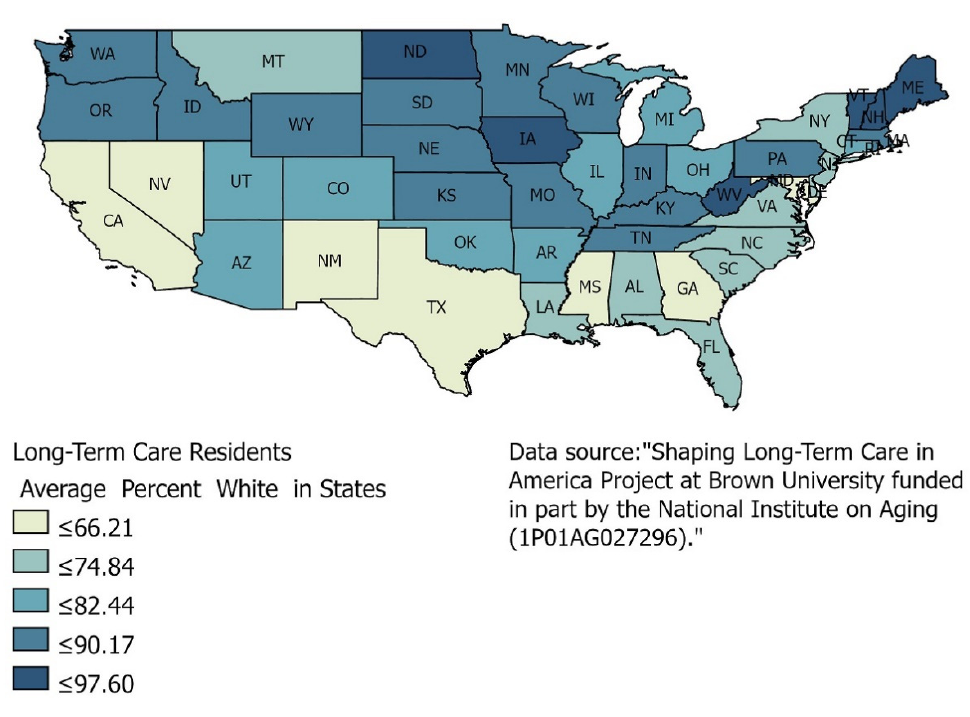
Figure 2. Percentage of White population in nursing homes.